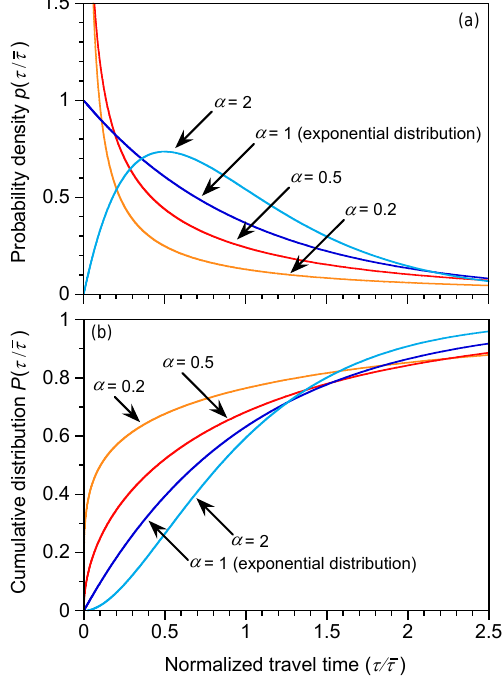
Figure 2. Gamma distributions for the range of shape factors α = 0.2–2 considered in this analysis. Horizontal axes are normal- ized by the mean transit time τ and thus are